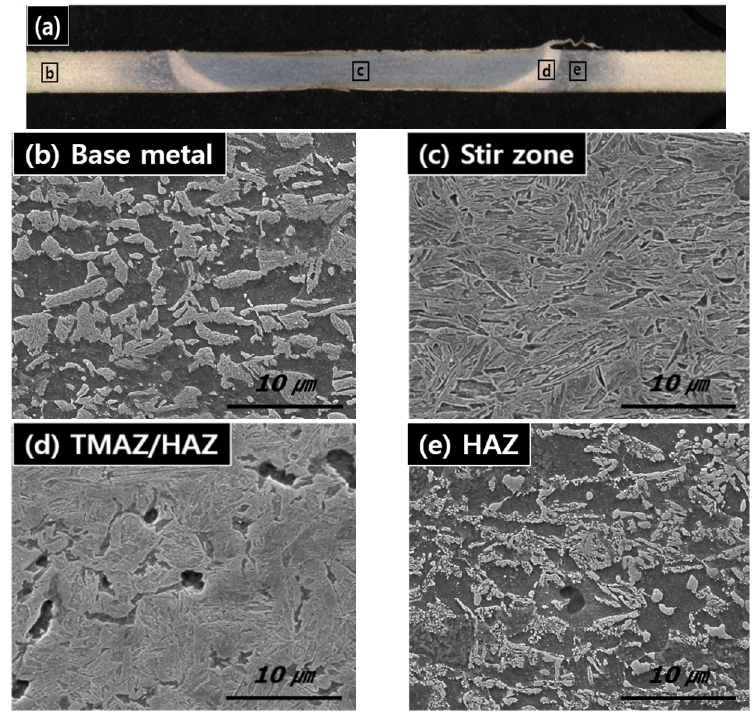
Figure 4. Microstructure of the DP980 FWS joints: ( a ) joint macrograph; ( b ) base metal (BM); ( c ) stir zone (SZ); ( d ) thermo ‐ mechanically affected or heat affect zone (TMAZ/HAZ); ( e ) HAZ.